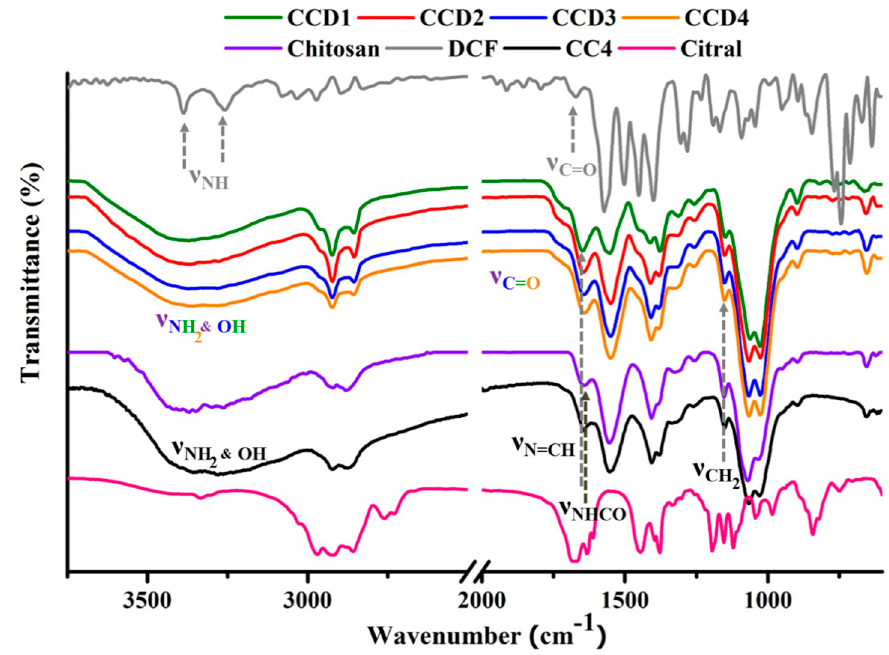
Figure 1. FTIR spectra of chitosan, citral, reference xerogel sample CC4 , diclofenac sodium salt ( DCF ), and drug delivery systems CCD1-CCD4 .